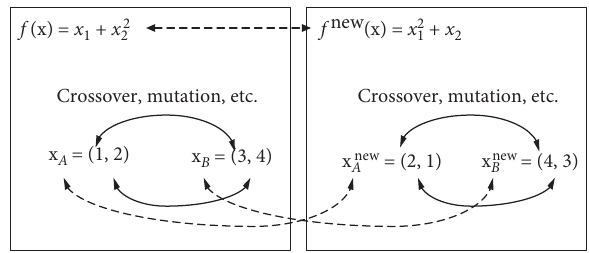
Figure 2: Corresponding relationship between two individuals before and after changing the order of variables for single-objective optimization